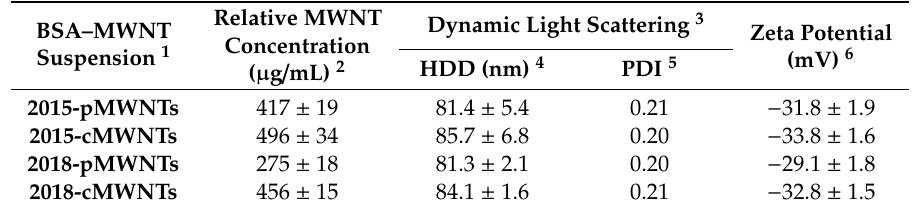
Table 2. Particle size and zeta potential analyses of purified bovine serum albumin (BSA)-MWNT